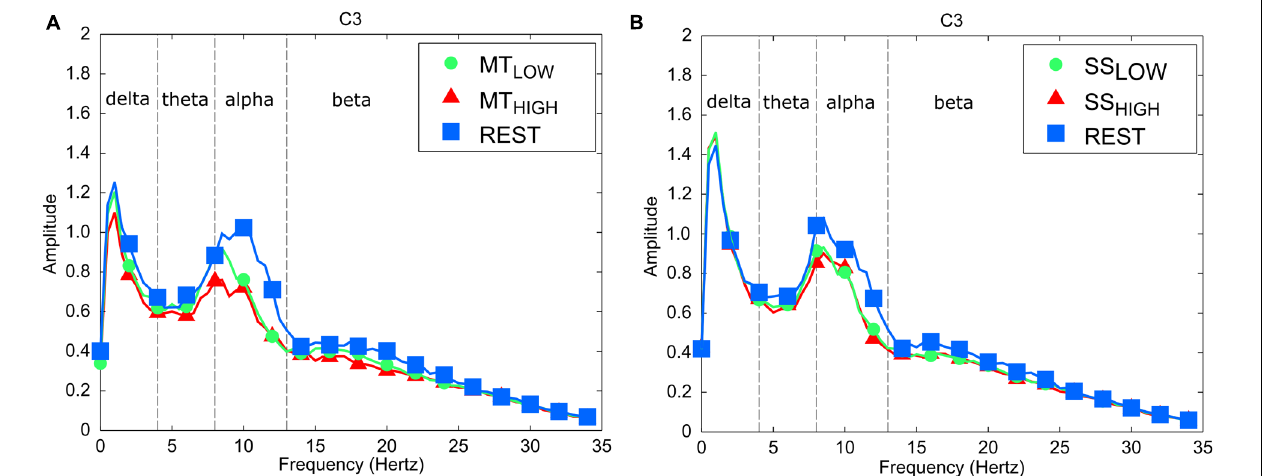
FIGURE 3 | Frequency spectra depicting characteristic power changes around the contralateral sensorimotor cortex (C3) averaged over all subjects. Spectrum with blue squares depicts the rest condition. Spectrums with green circles and red triangles depict the experimental conditions performed with low and high intensity, respectively. (A) Execution of the MT leads to a significant mu event-related desynchronization (ERD) in comparison to the rest condition for low and high task intensities. There was no significant difference in mu ERD between execution of the MT with low and high intensity. (B) Sensory stimulation (SS) leads to a significant mu ERD compared to the rest condition. The mu ERD caused by SS was smaller than the mu ERD caused by the MT. There was no significant difference in mu ERD between SS with low and high